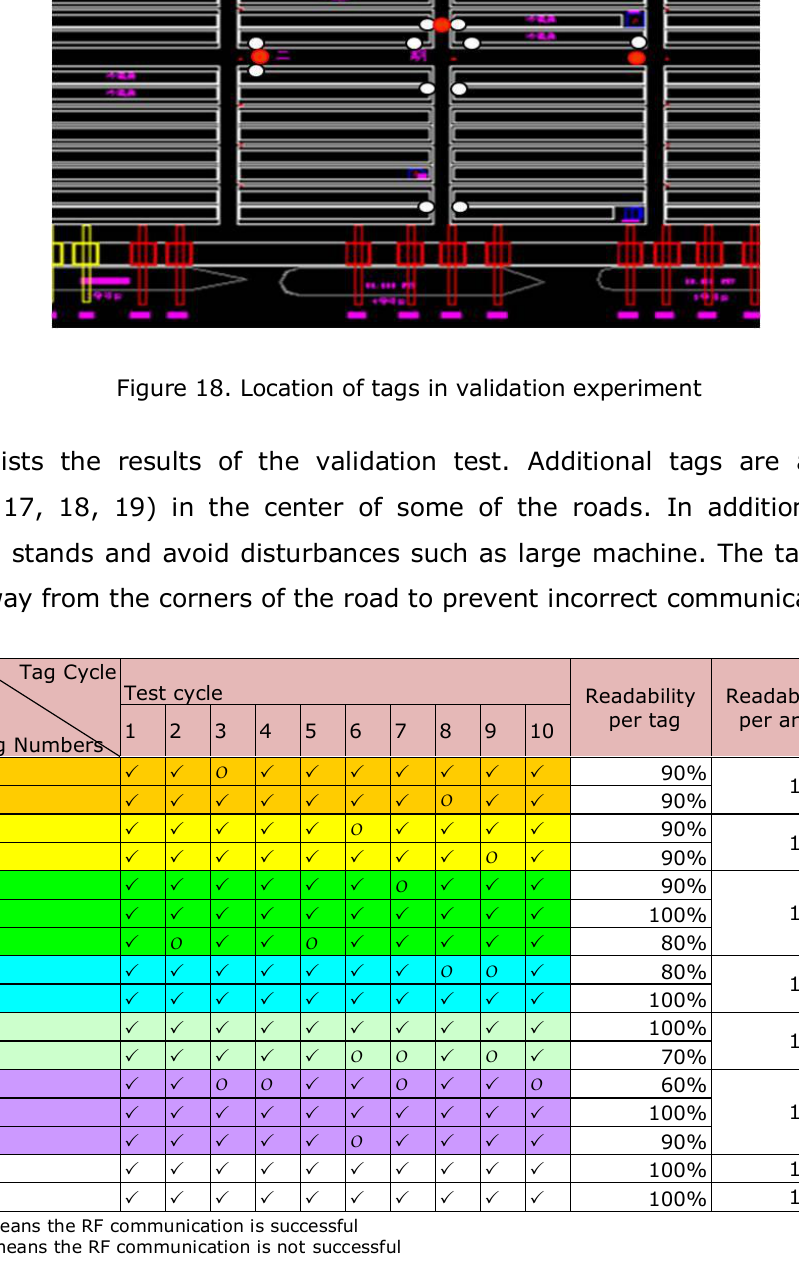
Table 5. Results of validation